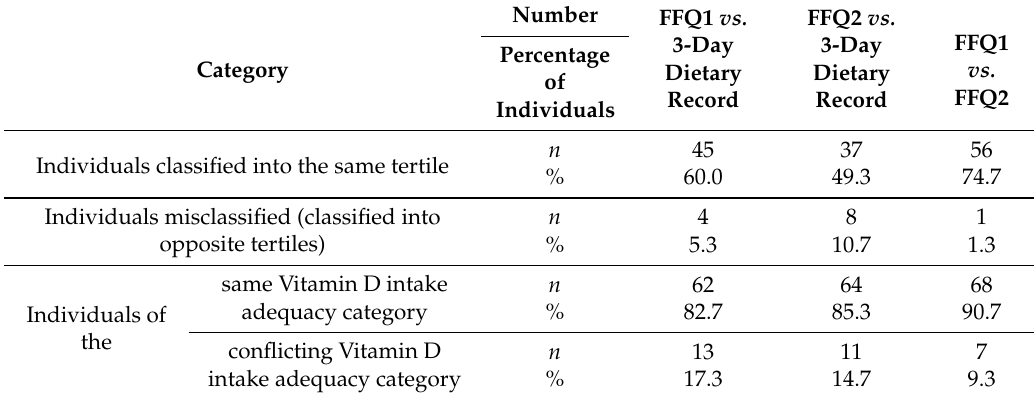
FFQ1—VIDEO ‐ FFQ filled out right after conducting 3 ‐ day dietary record; FFQ2—VIDEO ‐ FFQ filled out six weeks after FFQ1.